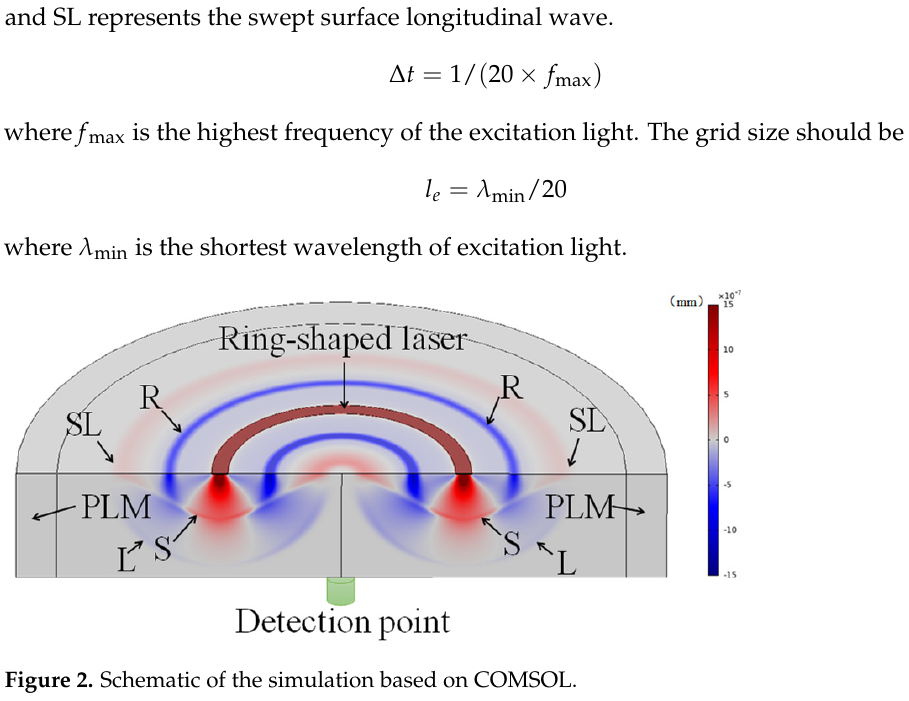
Figure 1. Flow chart of the proposed algorithm .